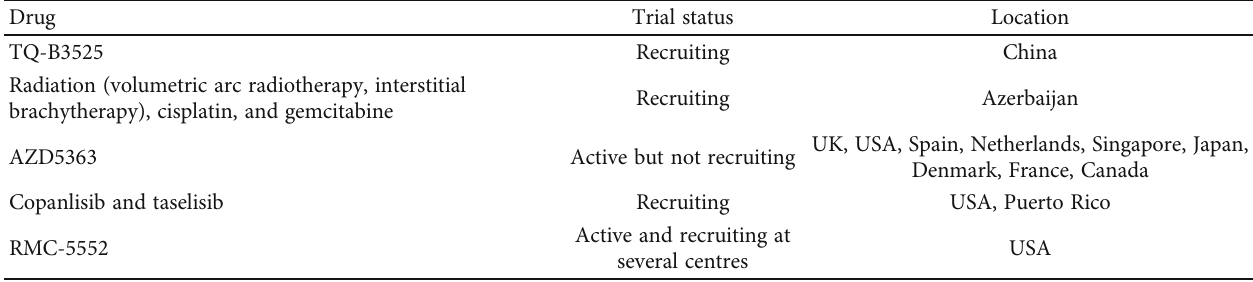
Figure 1: Type of PIK3CA mutations in various cancers of the cervix. Somatic mutations observed are shown. Green dots represent each case of the indicated mutation, and purple and black dots represent truncating alterations. Table 2: Inhibitors of PIK3CA approved or being tested against cervical